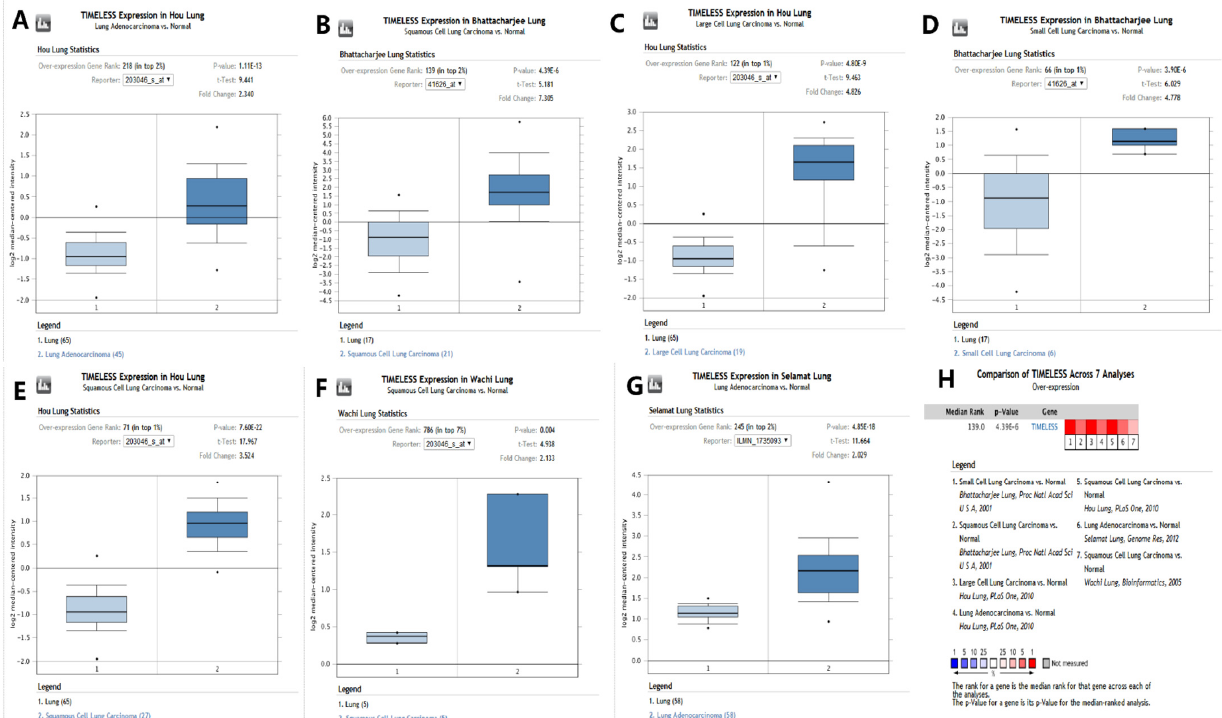
Figure 2. Expression profile of the Timeless gene from ( A – G ) Oncomine database. Expression profile of Timeless gene in seven lung cancer datasets. ( H ) Comparison of Timeless gene in the seven